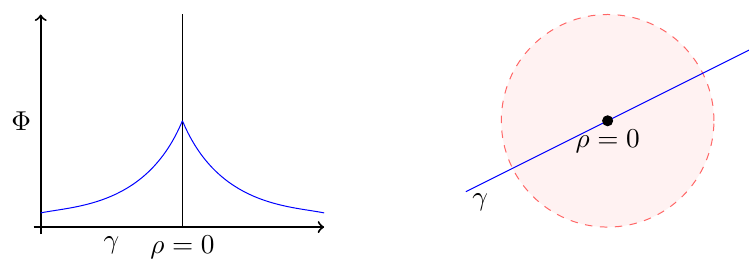
Figure 1 . The value of a scalar function along a path through the